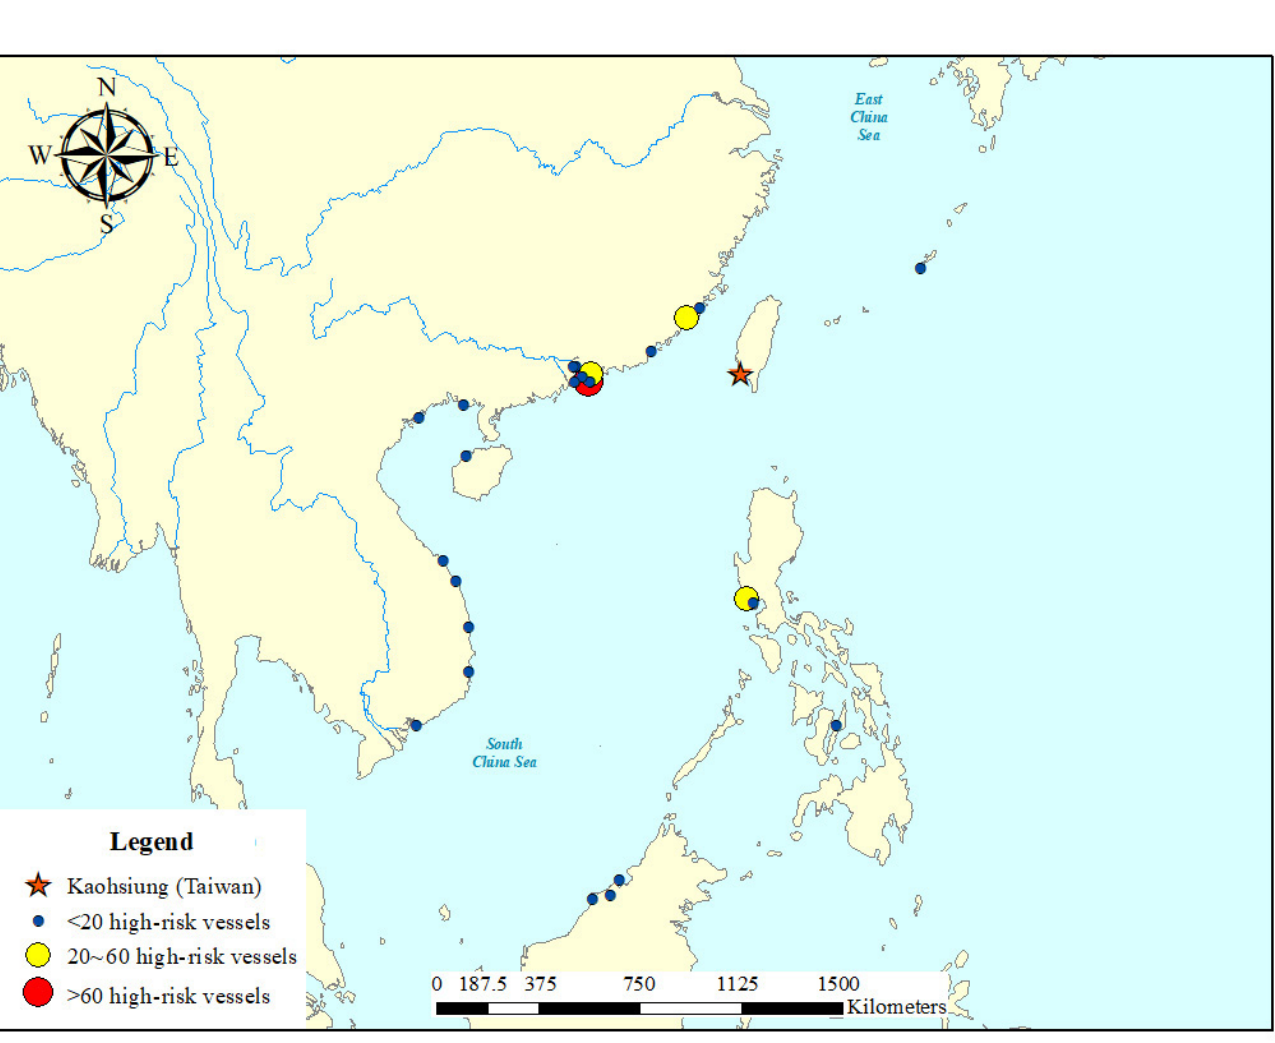
Figure 2. The results of the two-tier risk analysis performed for the incoming vessels to the port of Kaohsiung.